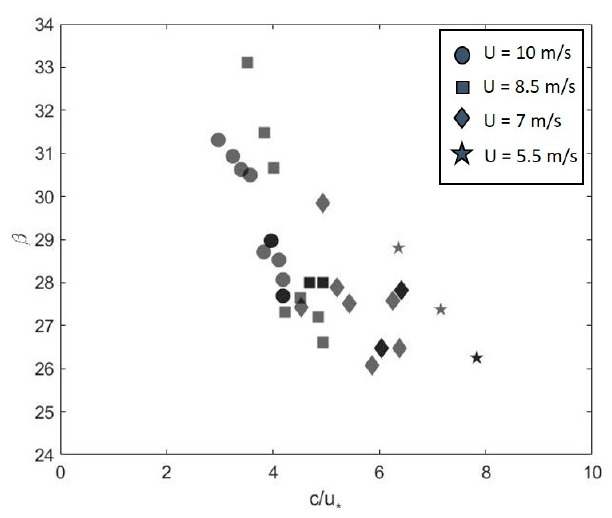
Figure 5. Growth rate coefficient, β , versus wave age for all irregular waves.